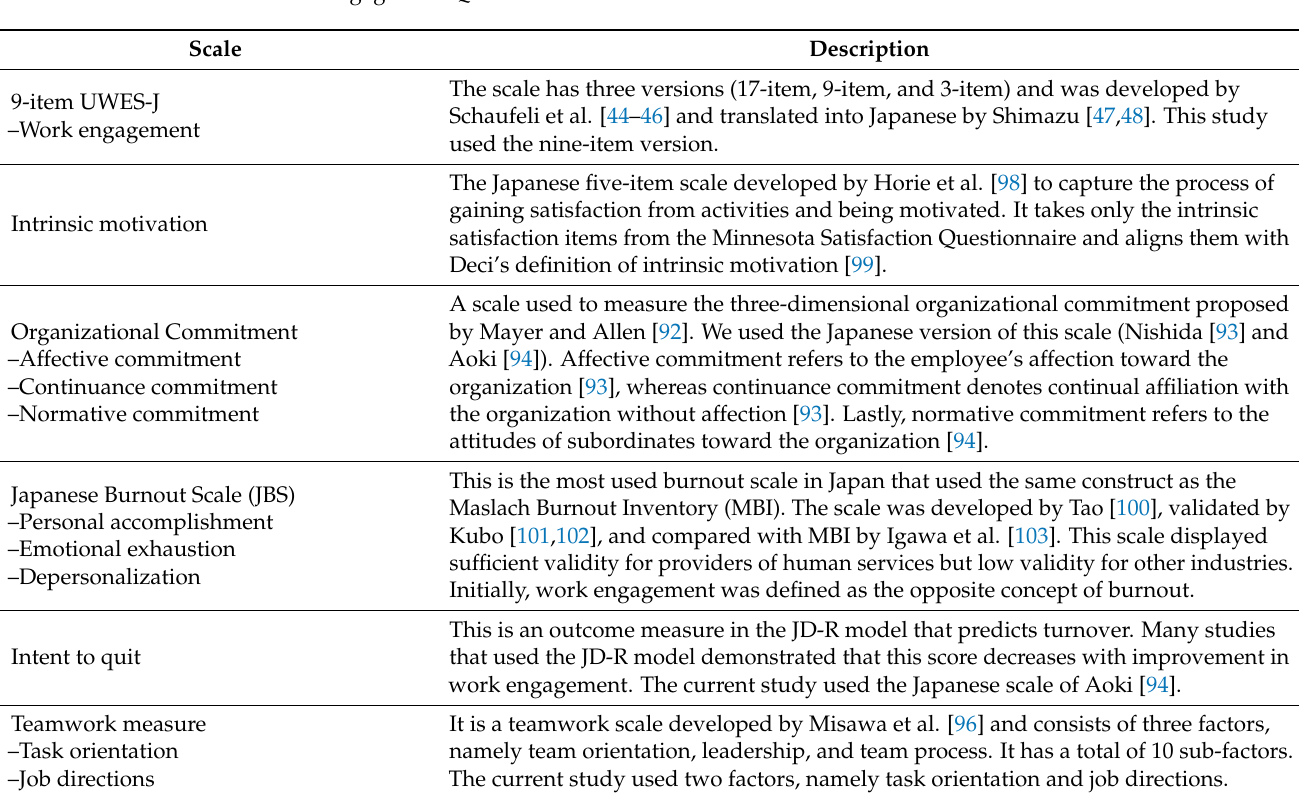
Table A3. Valid and reliable Japanese scales for the construct validity test of the Organizational Engagement